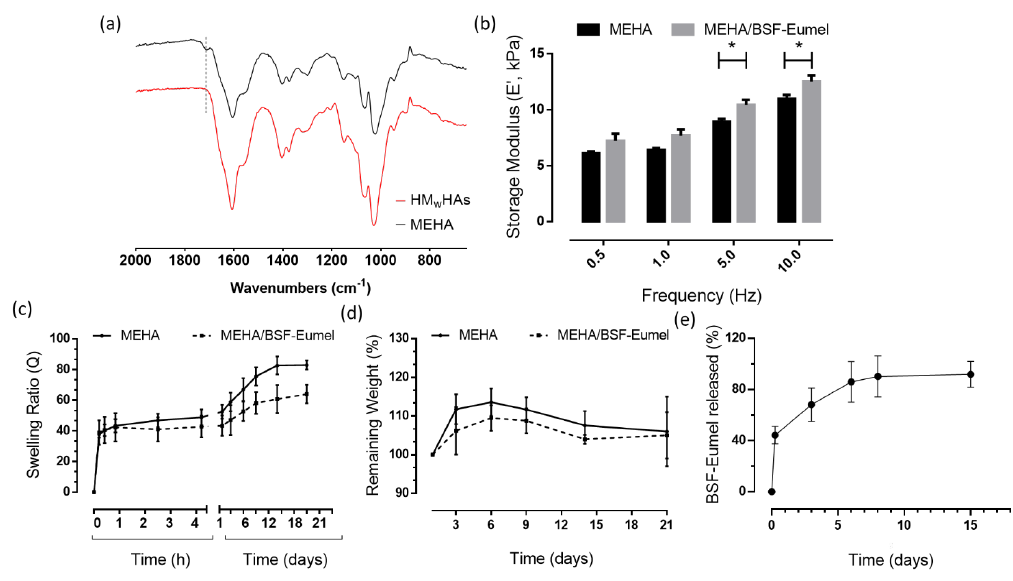
Figure 6. ( a ) ATR-FTIR spectra of HMwHAs and MEHA, highlighting the success of chemical modification. ( b ) Dynamic mechanical analysis performed on MEHA and MEHA/BSF-Eumel scaffolds. * p < 0.05. ( c ) Swelling behaviour and ( d ) degradation profile of MEHA and MEHA/BSF-Eumel scaffolds up to 21 days. ( e ) Release profile of BSF-Eumel from 3D printed scaffolds up to 15 days in diH 2 O. Data reported as mean value ± S.D., n = 3.